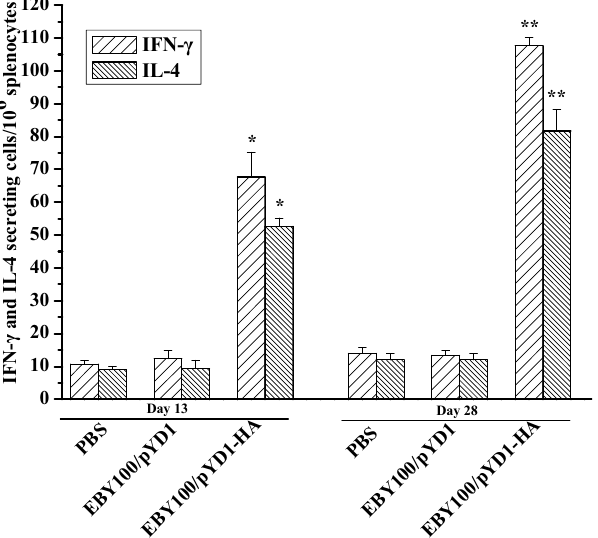
Figure 3. Cellular immune responses induced by oral administration of EBY/pYD1-HA. IFN-γ- and IL-4- secreting cells (n = 5 chickens per group) were separately analyzed by ELISpot assay. Asterisks indicate significant difference compare with the PBS- and EBY100/pYD1 controls. * p ˂ 0.05, ** p ˂ 0.01.